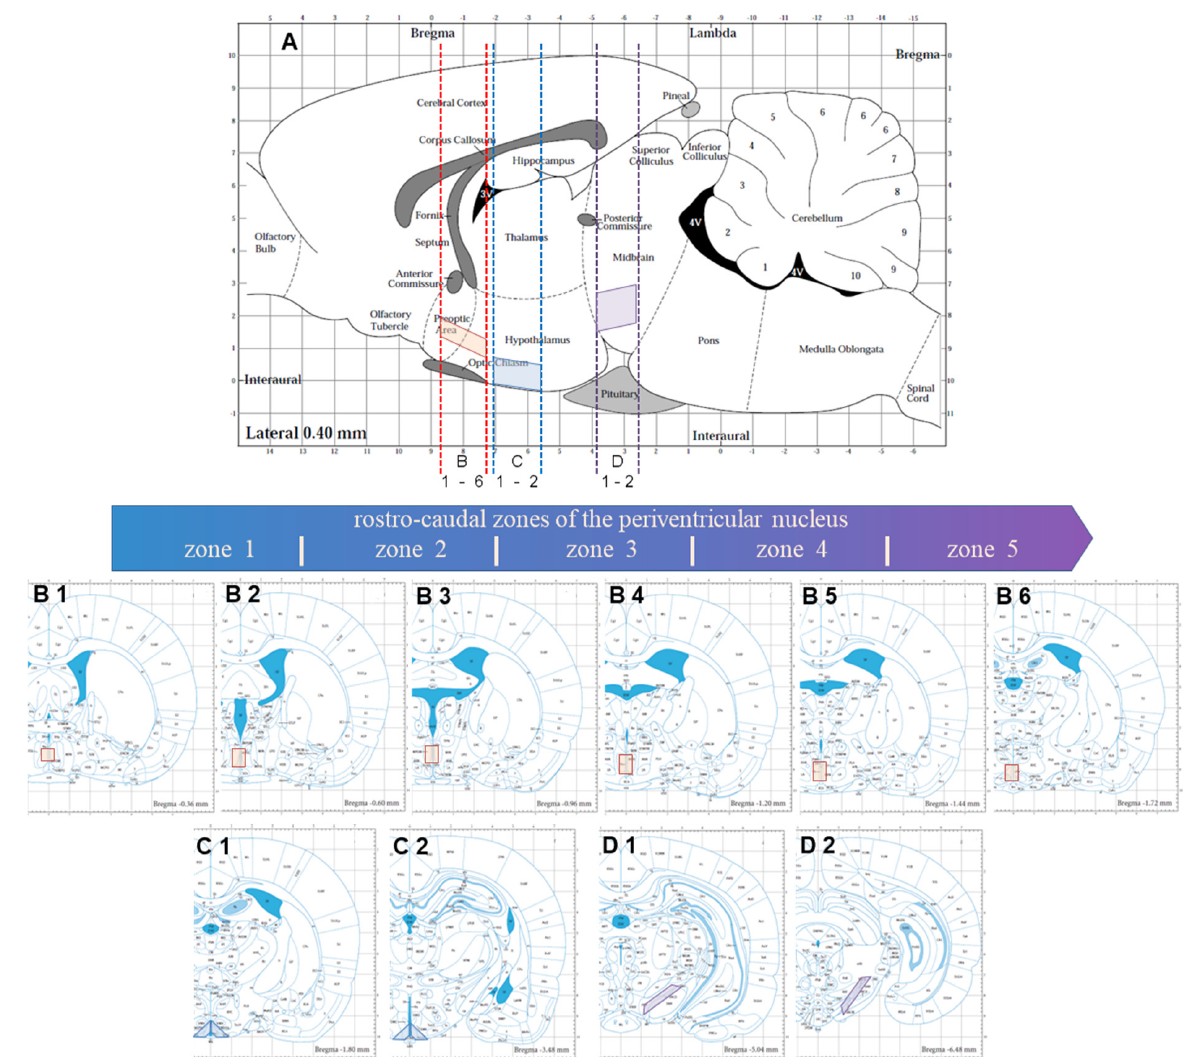
Figure 11. Scheme of obtaining frontal vibratome sections, 300 μ m thick, of the brain in the rostro-caudal direction at a frontal level corresponding to the periventricular nucleus (PeVN) with conditionally allocated zones ( B ) 1–6, as well as the arcuate nucleus (AN) with zones ( C ) 1,2, and the substantia nigra (ES) with zones D1,2, according to the rat brain steriotaxic atlas [50]. ( A ) the sagittal plane of the brain; ( B – D ) the frontal planes of the brain; red frames, borders of the selected brain regions: PeVN, AN, and